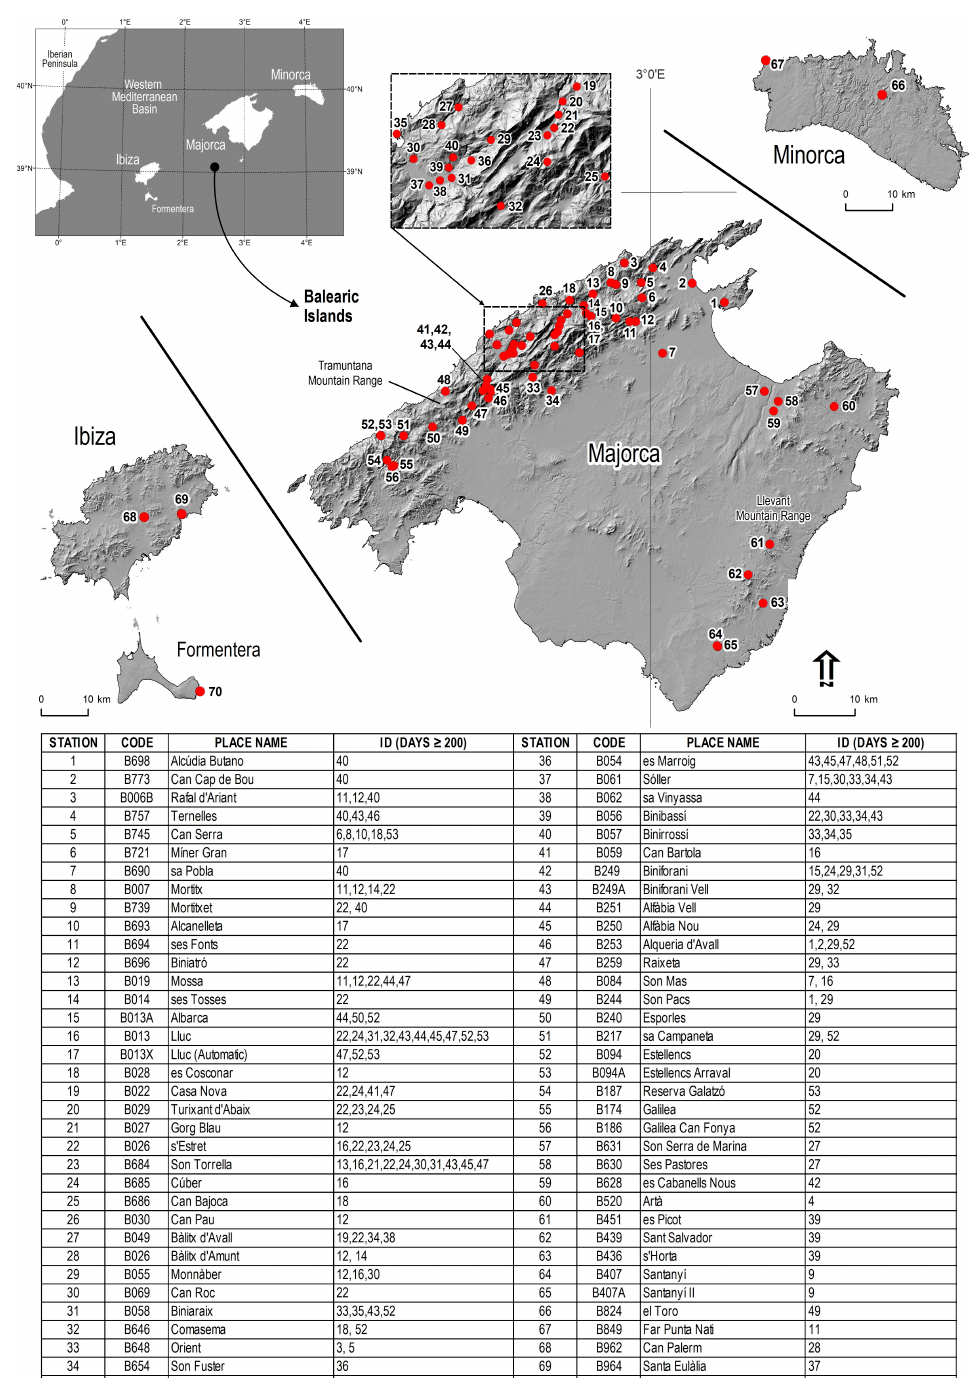
Figure 3. Meteorological observatories of the Balearic Islands with rainfall equal to or greater than 200 mm during the period 1941–2010. The table below indicates the official code of the observatory (CODE), the place name (PLACE NAME) and the IDs of the days on which 200 mm (DAYS ≥ 200) has been reached. The date to which each ID corresponds can be consulted in the table in the Appendix A.